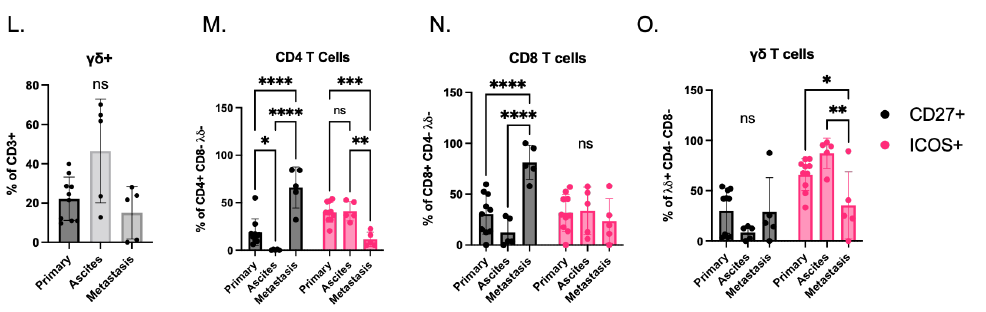
Figure 2. Lymphoid cell profiling of immune cells isolated from different sites in the STOSE.M1 luc murine ovarian intrabursal cancer model: ( A – C ) Uniform manifold approximation and projection (UMAP) plots overlayed with FlowSOM (Flow self-organizing map) of tumor infiltrating immune cells (CD45 + ) isolated from STOSE.M1 luc ovarian intrabursal model, propagated in FVB/NJ mice. Clustering was based on expression profiles of lymphoid cell surface markers. ( A ) Primary ovarian tumors ( n = 10). ( B ) Ascites ( n = 5). ( C ) Metastases ( n = 5). Each dot represents an individual cell. ( D ) Percentages of T and B cells in each site of STOSE.M1 luc model. ( E ) Percentage of B cells (CD3 − CD19 + B220 + ). ( F ) Percentage of Memory B cells (CD3 − CD19 + B220 + CD27 + ). ( G ) Percentage of MHCII + B cells. ( H ) Percentage of T cells subsets in each site of STOSE.M1 luc model. ( I ) Percentage